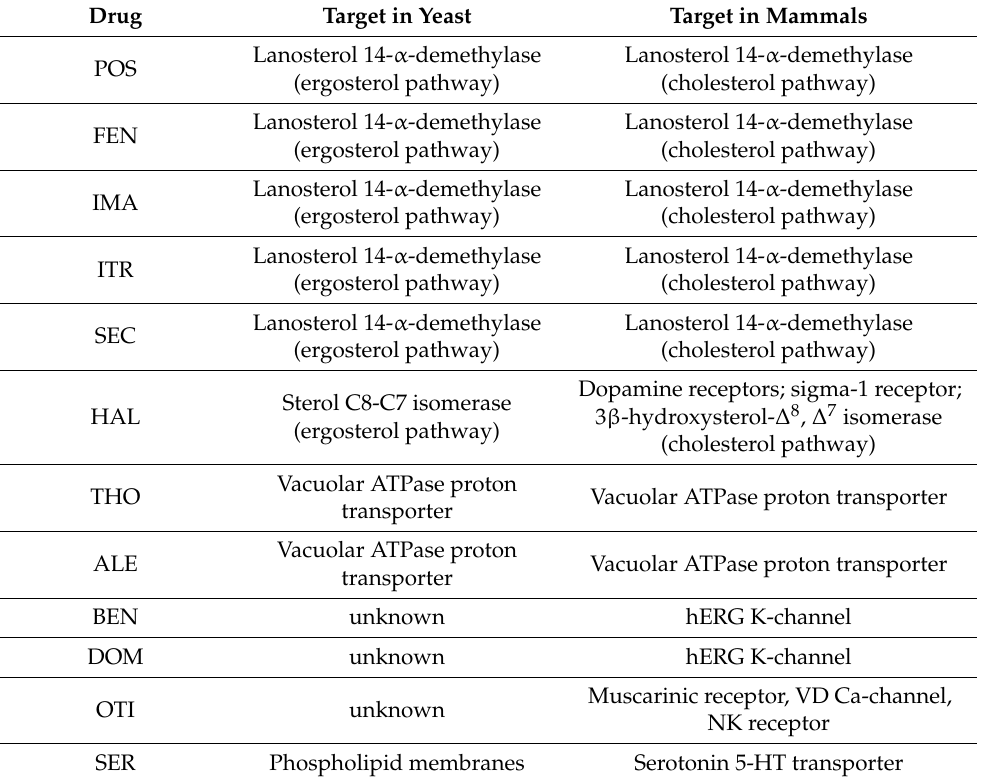
Table 1. Yeast and mammalian target of the active compounds identified by drug drop test. hERG = ether-a-go-go-related gene; VD = voltage-dependent; NK = natural killer; 5-HT = 5-hydroxytryptamine. Drug Target in